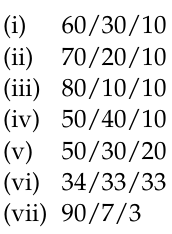
Figure 8. Calculated DF factor maximal, minimal, and average values.